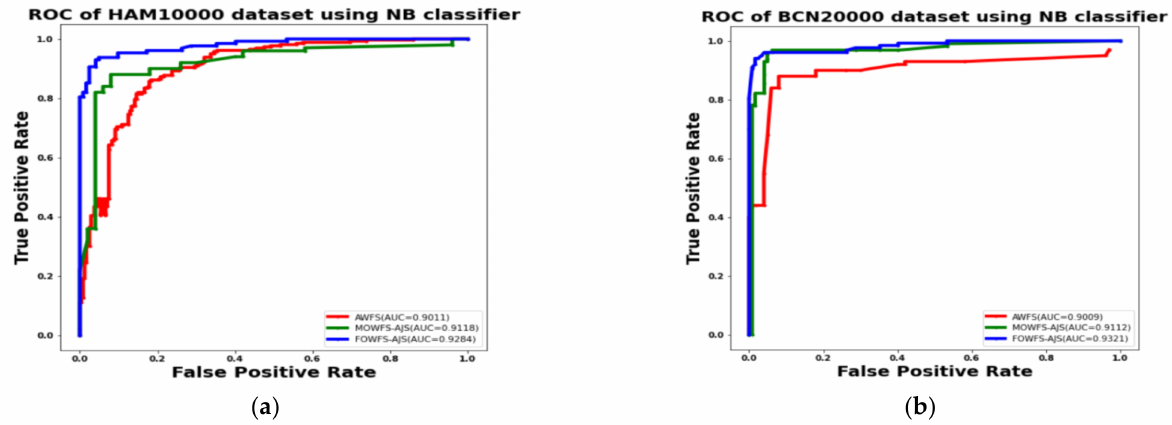
Figure 11. ROC using NB classifier for ( a ) HAM 10000 dataset and ( b ) BCN 20000 dataset.